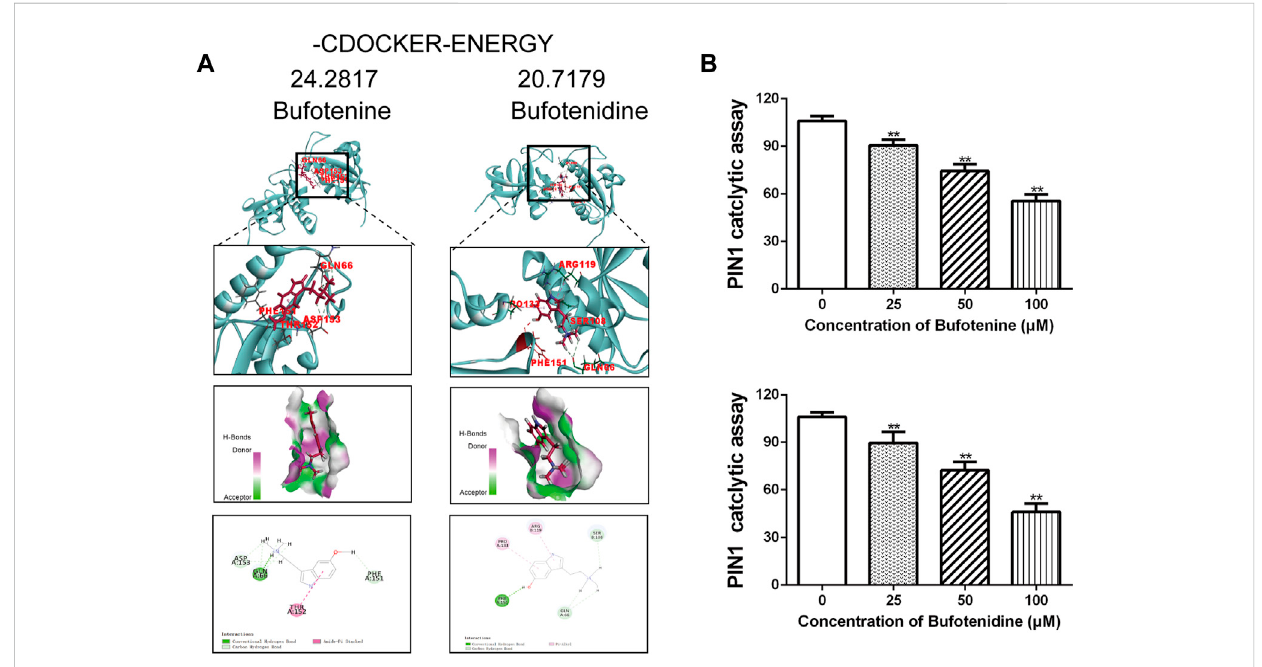
Effects of potential candidate compounds of CI on PIN1. (A) Docking simulations of PIN1 with bufotenine and bufotenidine. (B) PPIase isomerase inhibition assay of PIN1 with bufotenine and bufotenidine. Data is the average of independent experiments ±SEM. * p < 0.05, ** p < 0.01 vs . control group (one-way